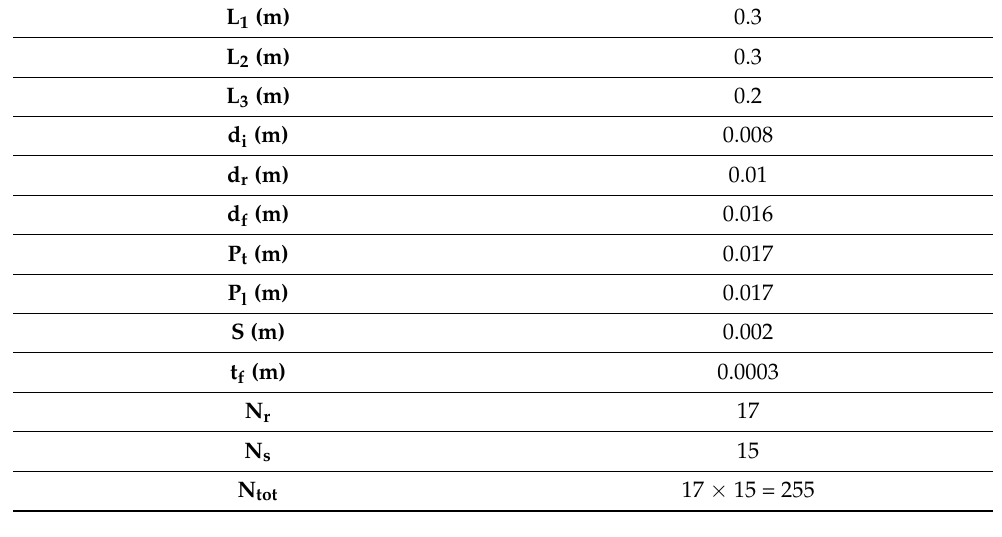
Table 3. The condenser’s main dimensions.